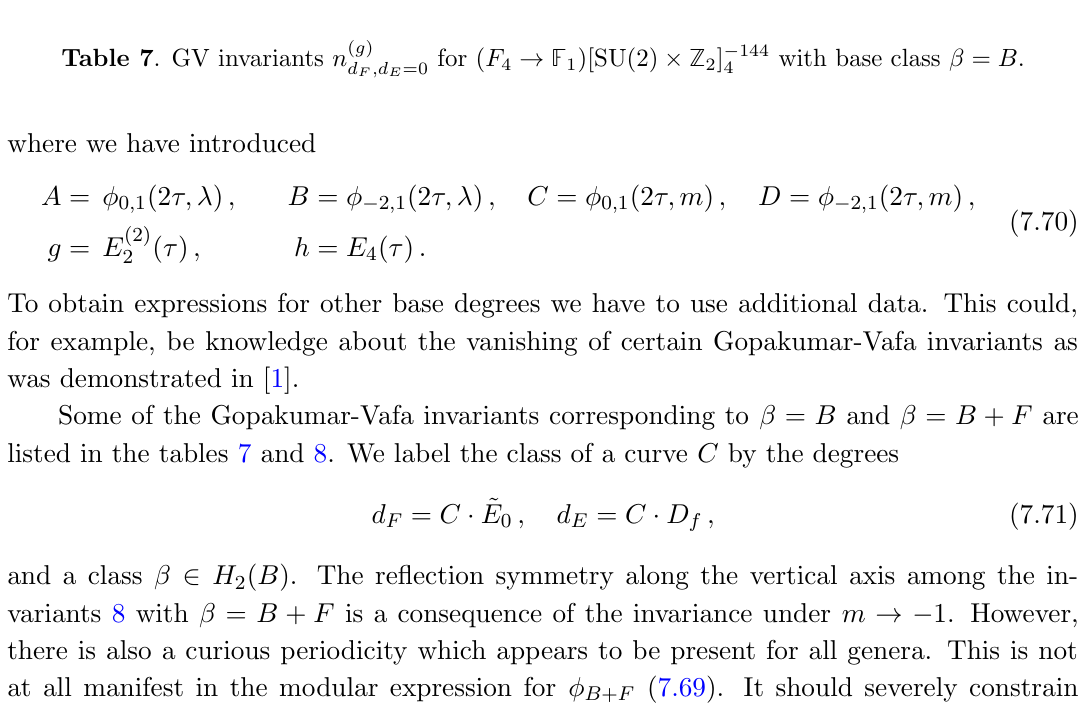
Table 7 . GV invariants n ( g )